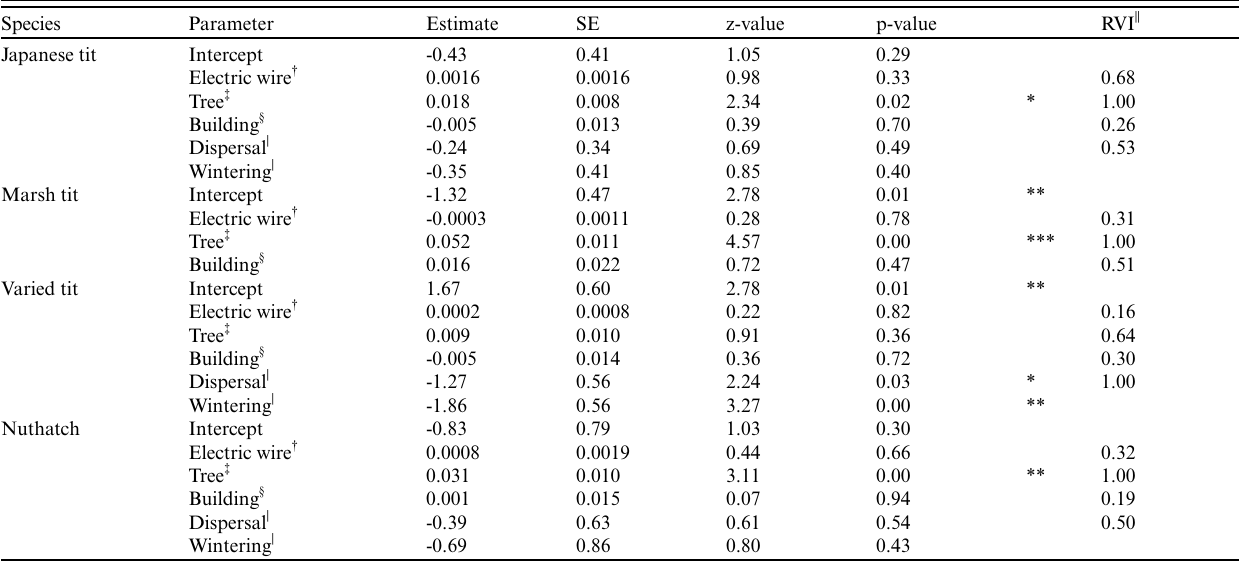
Table 2 . Results of model averaging for four species in three